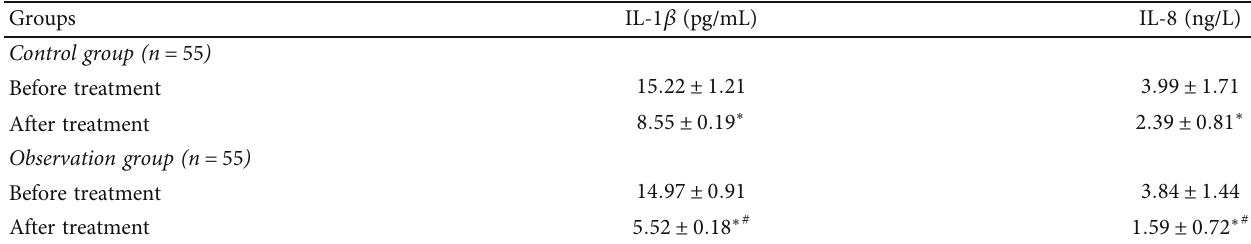
Table 5: Levels of in fl ammatory factors tested before and after treatment in both